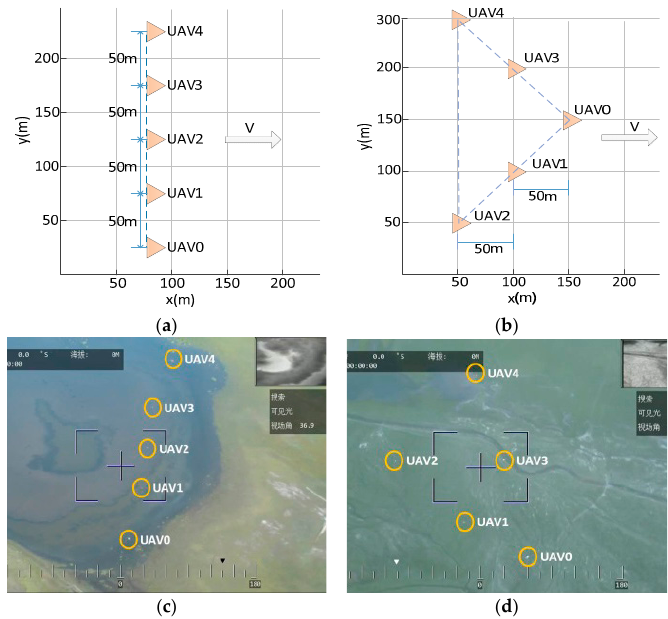
Figure 10. Configurations of five drones. ( a ) Designed lateral configuration; ( b ) Designed wedge configuration; ( c ) Real time lateral configuration; ( d ) Real time wedge configuration.